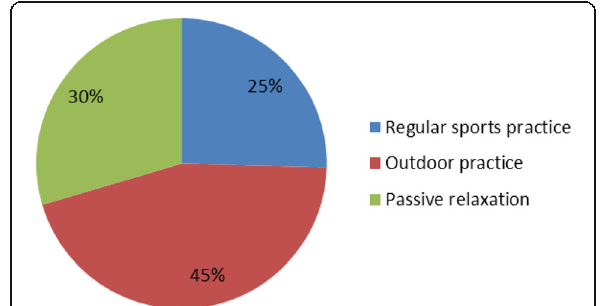
Fig 11. The way of spending free time by children.